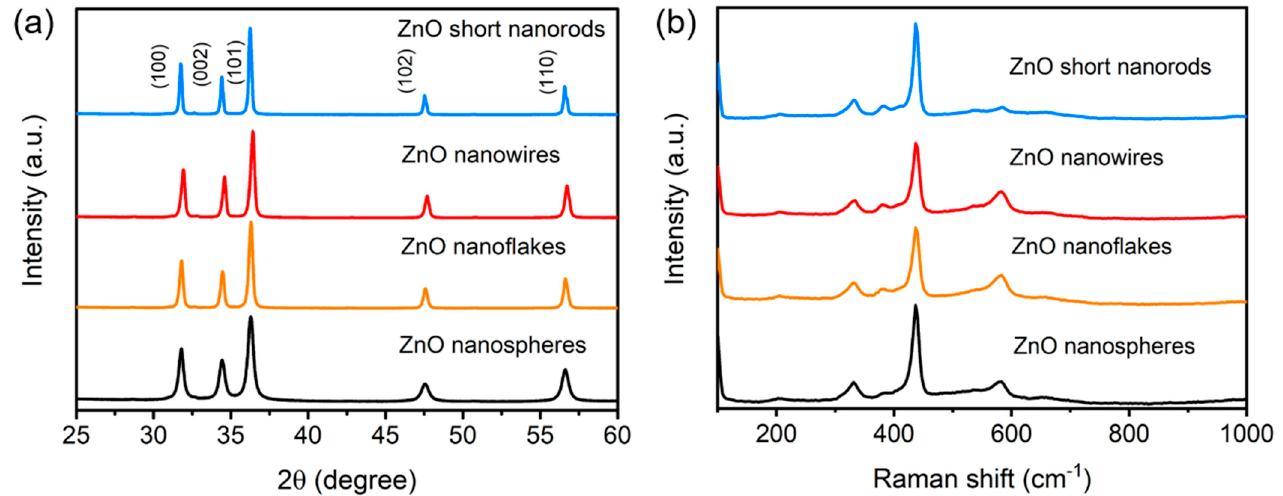
Figure 1. ( a ) XRD patterns of ZnO samples with four different morphologies. ( b ) Raman spectra of ZnO samples with four different morphologies.